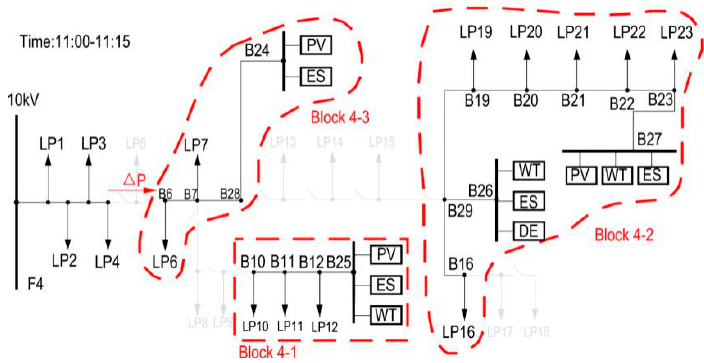
Figure 7. 10:00–10:15 division of decision-making body.